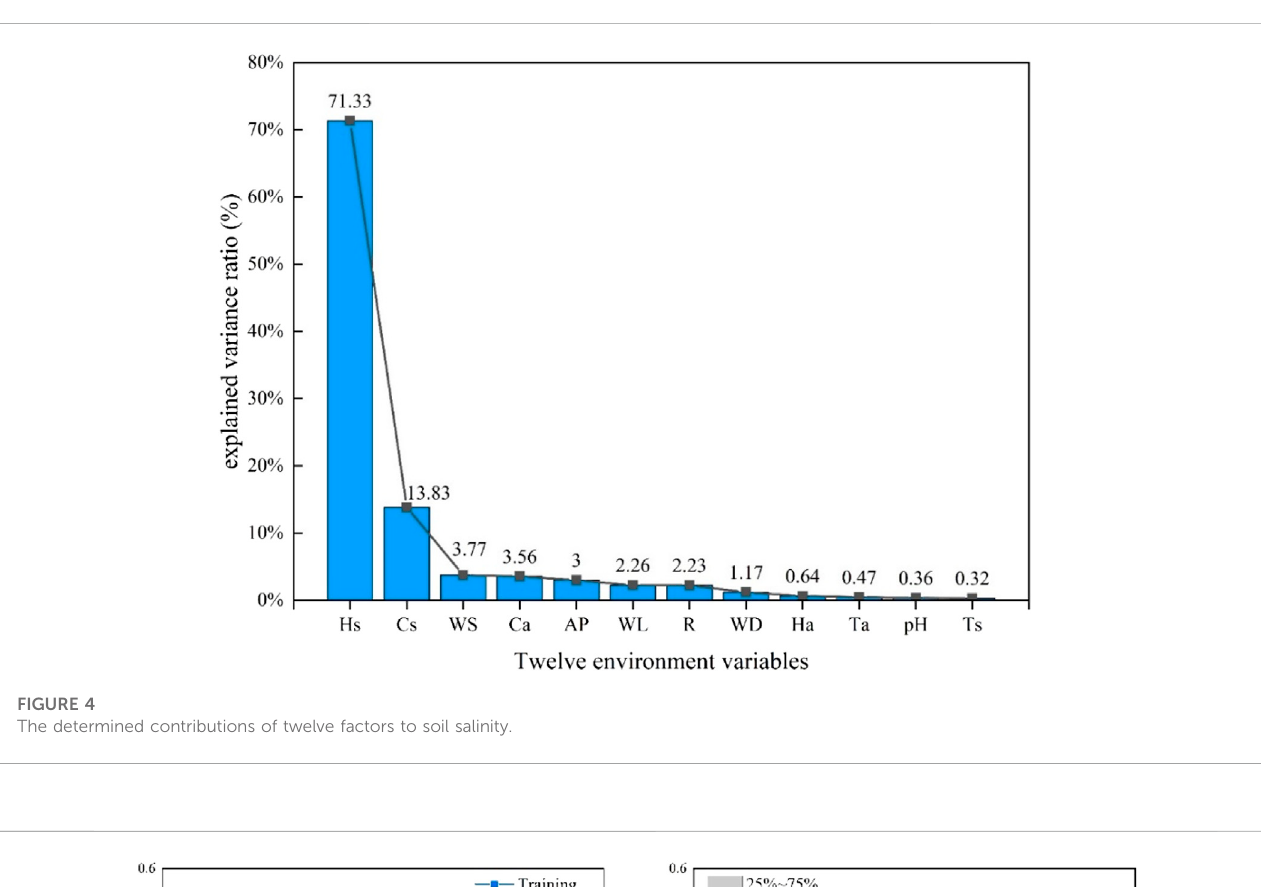
FIGURE 4 The determined contributions of twelve factors to soil salinity.